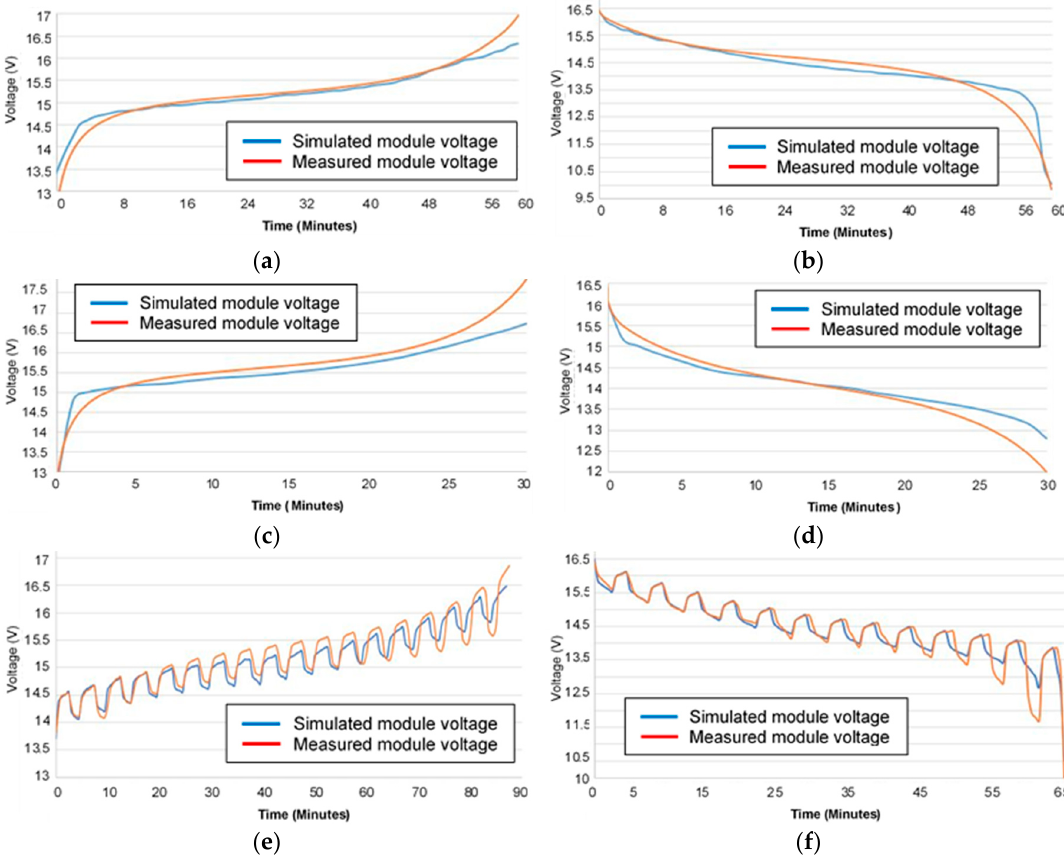
Figure 10. Comparisons of module simulated and experimental charging / discharging curves: ( a ) Simulated and test of 20 A charging in module; ( b ) simulated and test of 20 A discharging in module; ( c ) simulated and test of 40 A charging in module; ( d ) simulated and test of 40 A discharging in module; ( e ) simulated and test of 20A pulse charge in module; ( f ) simulated and test of 30A pulse discharge in module.